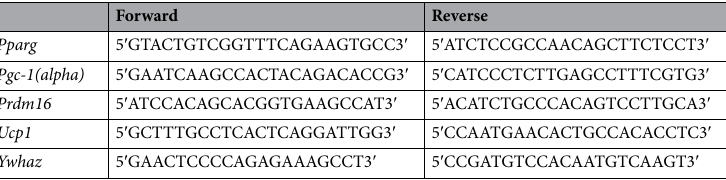
Table 1. This table represents the browning pathway gene sequence used for qPCR